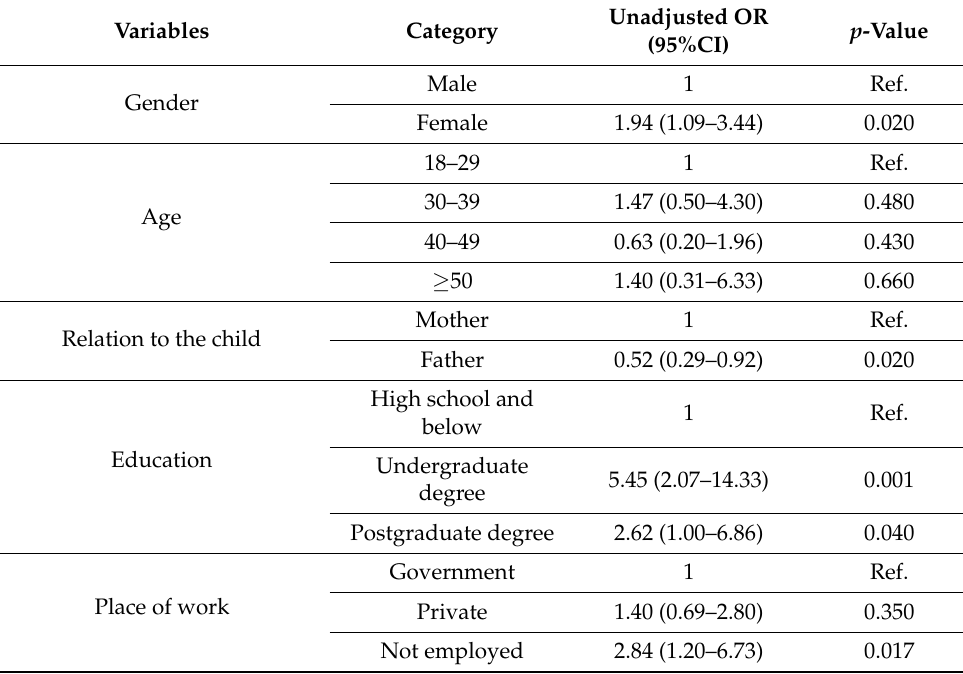
Table 2. Unadjusted crude analysis of the outcome of parents’ intention to give COVID-19 vaccine to their children and other covariates showing unadjusted odd ratios (ORs) and 95% confidence intervals